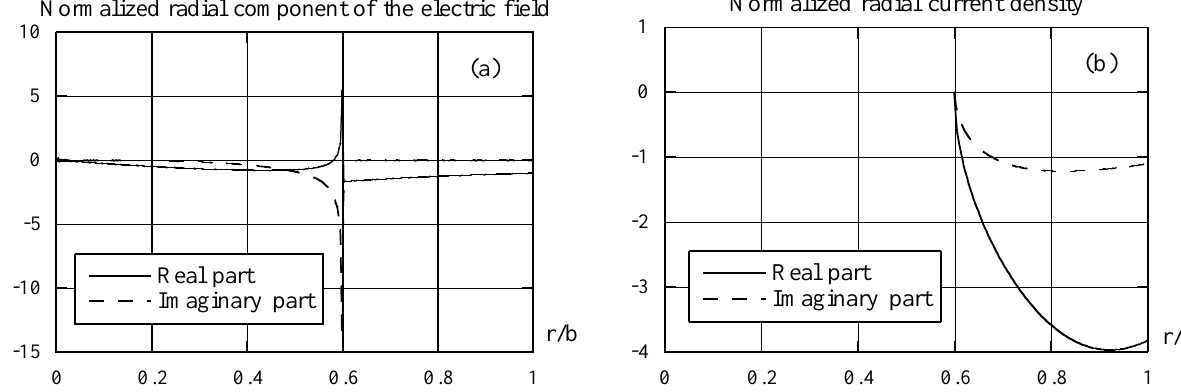
FIG. 2. The radial component of the electric field normalized at (cid:50) p (cid:98) (cid:121) z (cid:113) at the iris (a) and the radial current density normalized at (cid:50) p (cid:98) (cid:121) (cid:113) (b) in the case (cid:107)(cid:98) (cid:173) (cid:53) , (cid:119) (cid:173) (cid:51) (cid:121) (cid:53) , and b (cid:173)